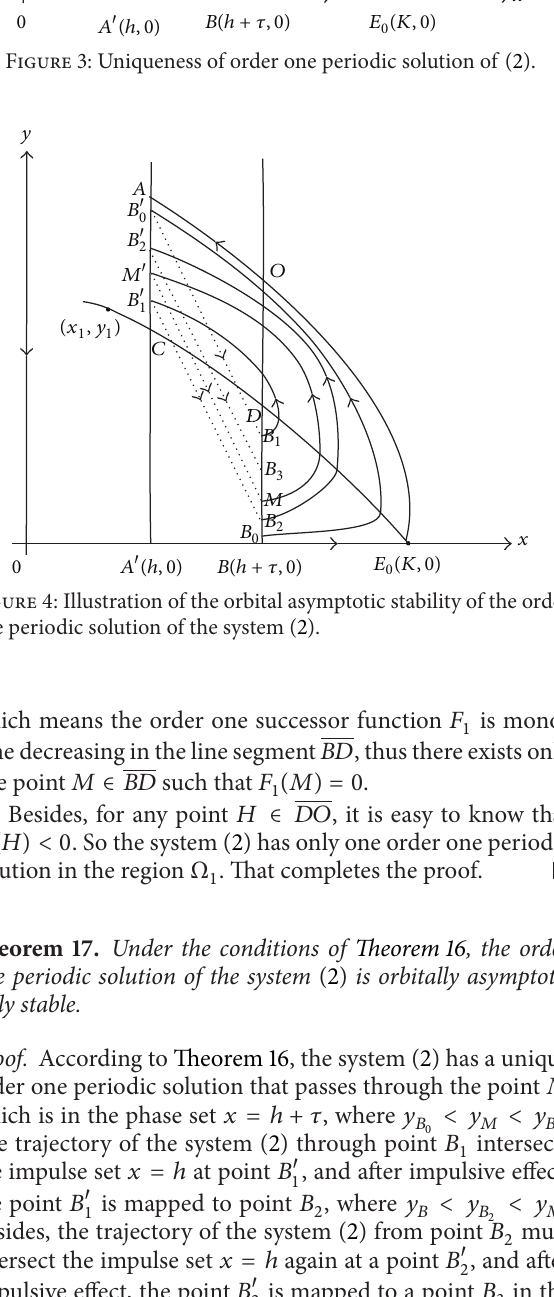
Figure 3: Uniqueness of order one periodic solution of (2).